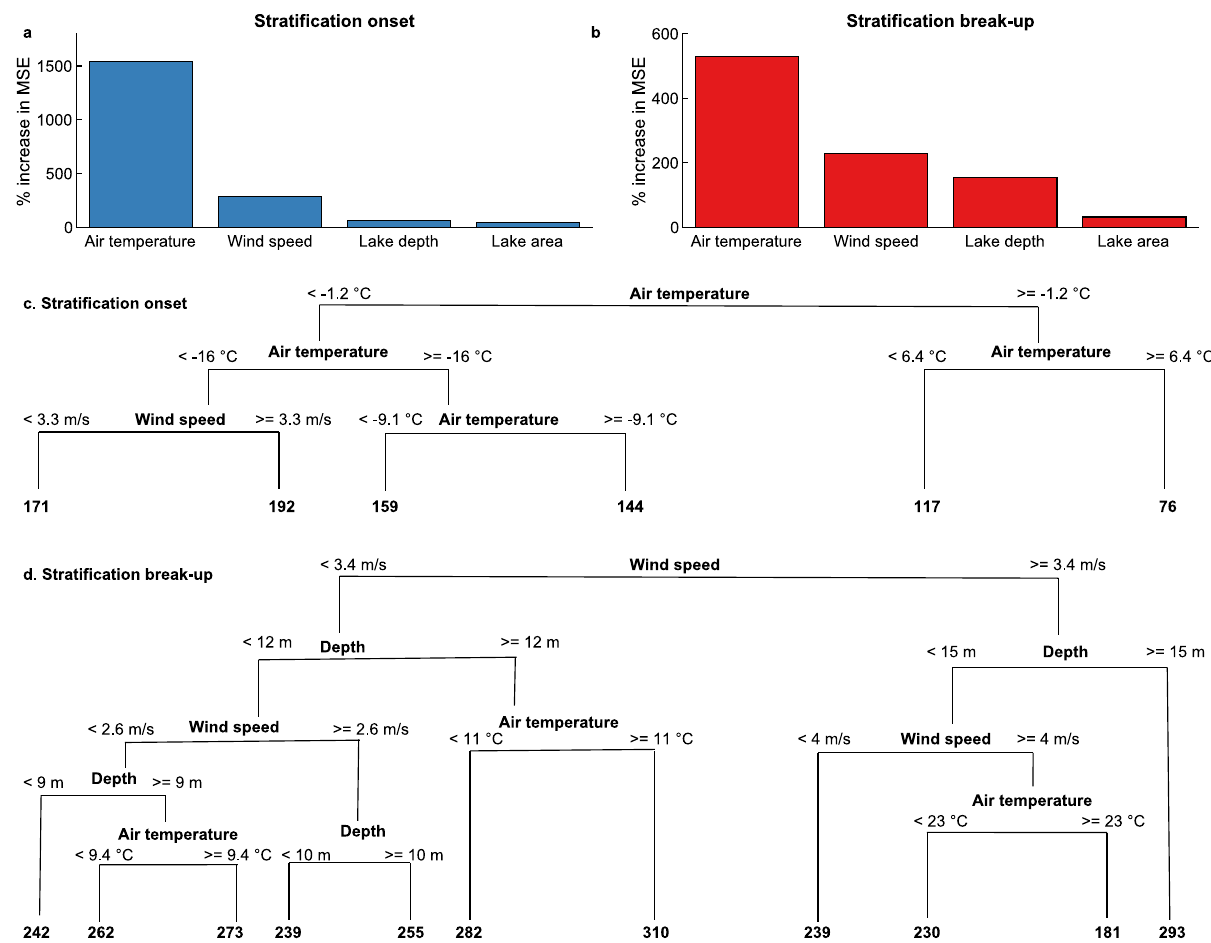
Fig. 2 Climatic and in-lake drivers of lake strati fi cation phenology. Importance of variables based on a random forest analysis in predicting a strati fi cation onset and b strati fi cation break-up. Variable importance is calculated as the percentage increase in mean square error (MSE) of predictions estimated with an out-of-bag coef fi cient of variation (CV) as a result of variables being permuted. Higher values indicate greater importance of a predictor variable to the set of decision trees. Regression tree showing the drivers of strati fi cation onset date ( c ) and strati fi cation break-up ( d ). The values below each of the leaves represent the date of strati fi cation (shown as the day of year) on average for the lakes found within each group. All results are based on the average simulations across the lake – climate model ensemble. Cold season is de fi ned as November – April and warm season is de fi ned as May –